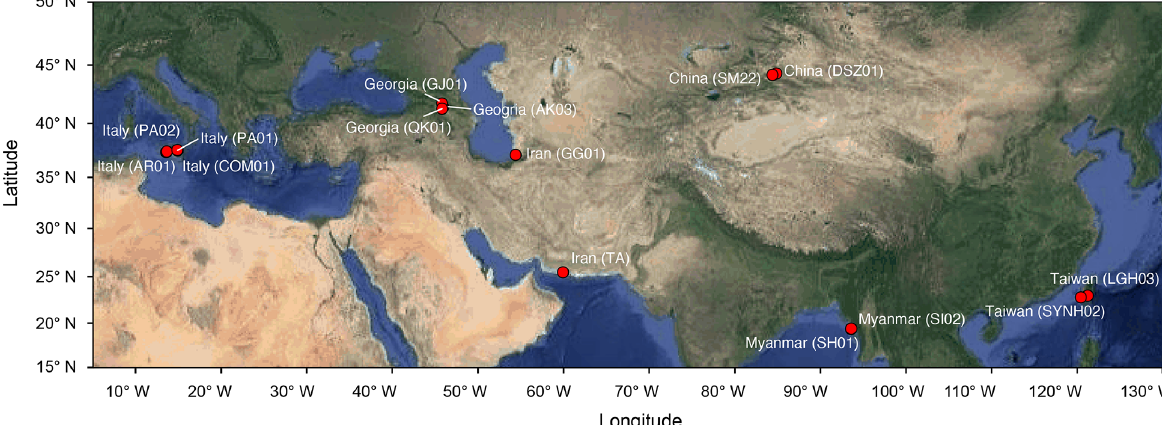
Figure 1. Map overlay with analyzed MVs (solid red circles). Country names are shown with MV codes in parentheses. The map is modified from © Google Maps 2021 using the ggmap package (Kahle and Wickham, 2013) in